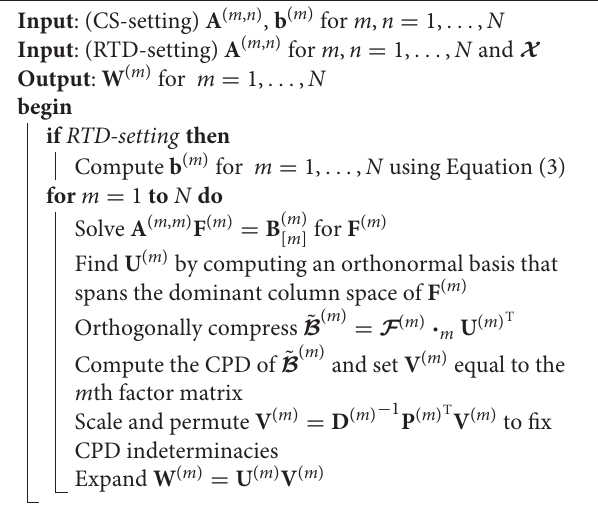
Algorithm 2: Orthogonally compressed CPD from a BRKS linear system ( lscpd_brks